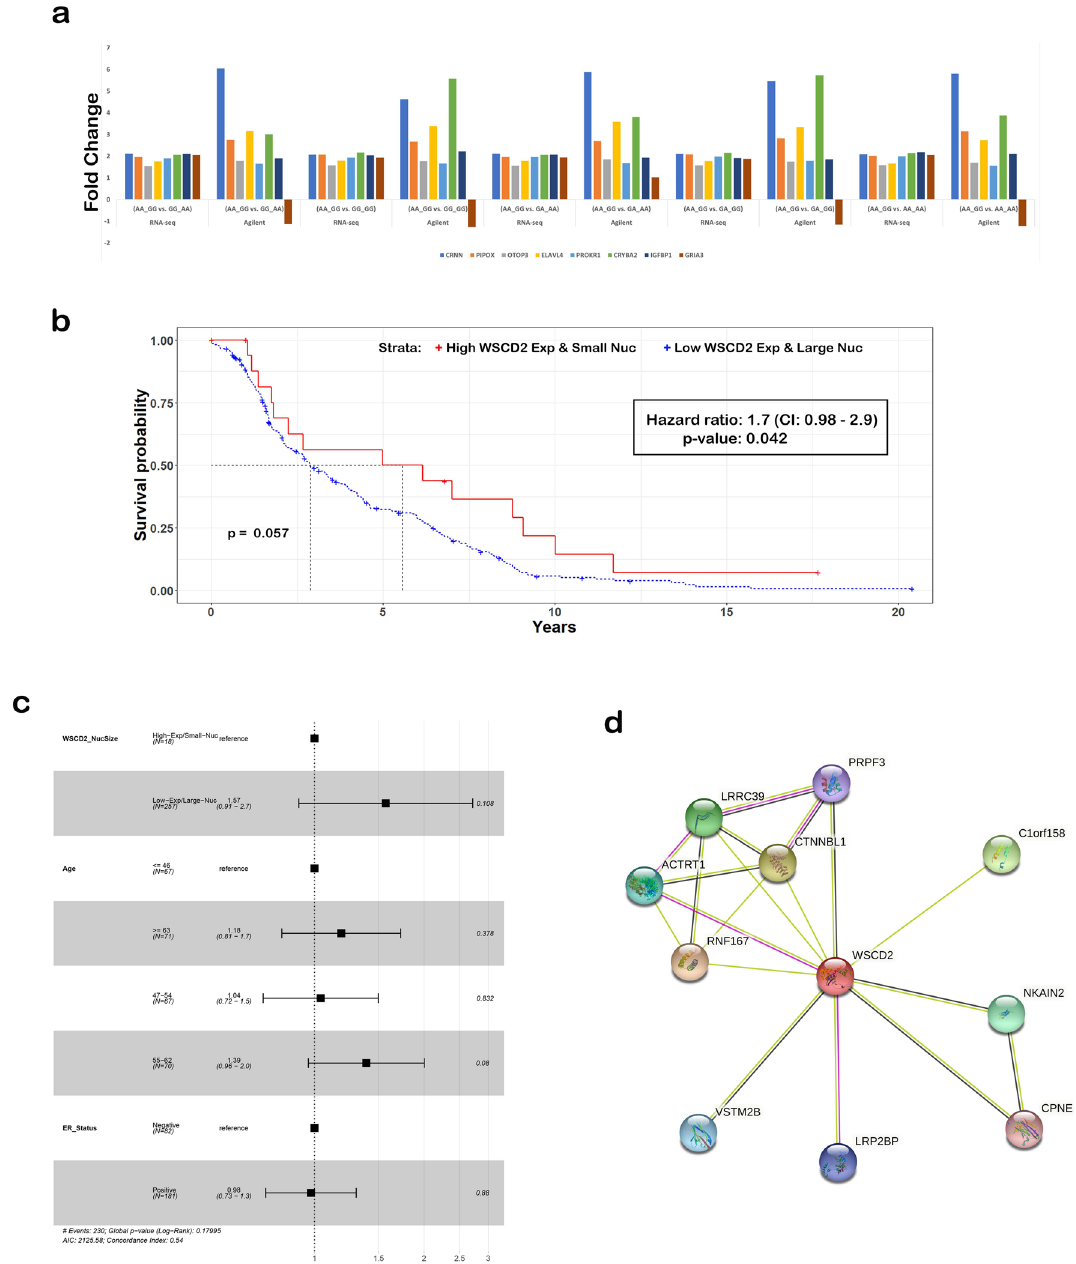
Figure 3. Gene expression validation, survival analysis and proteins interacting with WSCD2 . ( a ) Validation of 8 of the 16 RNA-Seq DEGs using Agilent gene expression data (log2 lowess normalized (cy5/cy3) collapsed by gene symbol) from 130 of the 286 TCGA patients that were available in the U.S. National Institutes of Health National Cancer Institute Genomic Data Commons legacy archive. The y-axis is fold change and the x-axis is the gene colored according to the legend as well as grouped by the comparison using either data from RNA-Seq or Agilent microarray. ( b ) Kaplan–Meier plot of time-to-event survival from 277 of the 286 TCGA breast cancer female patients on their bulk RNA-Seq RSEM expression of WSCD2 and nucleus mean Size Area data. The x-axis is years and the y-axis is survival probability. The red curve is the data for patients with high WSCD2 gene expression (> the 75th percentile) and small nuclei (< the 25th percentile) and the blue curve is the data from the other patients (low WSCD2 gene expression and large nuclei). The dashed black lines are the medians of survival for each strata and p is the log-rank p-value from testing the null hypothesis that each strata has the same survival probability. The hazard ratio value and statistical inferences for the parameter is shown in the inset. ( c ) Forest plot for Cox proportional hazards model. N is the number of patients, the hazard ratio is represented by the square, its confidence interval in parentheses and is represented by the horizontal lines, the vertical line represents 1.0 and the p-value for each predictor variable is to the right of the plot. ( d ) Search Tool for the Retrieval of Interacting Genes/Proteins (STRING) database 16 network of proteins that interact with the WSCD2 protein. Nodes are filled to denote that the 3D structure of the protein is known or predicted. Pink interactions are experimentally derived whereas lime or black colored interactions are derived by text mining literature or by gene co-expression analysis